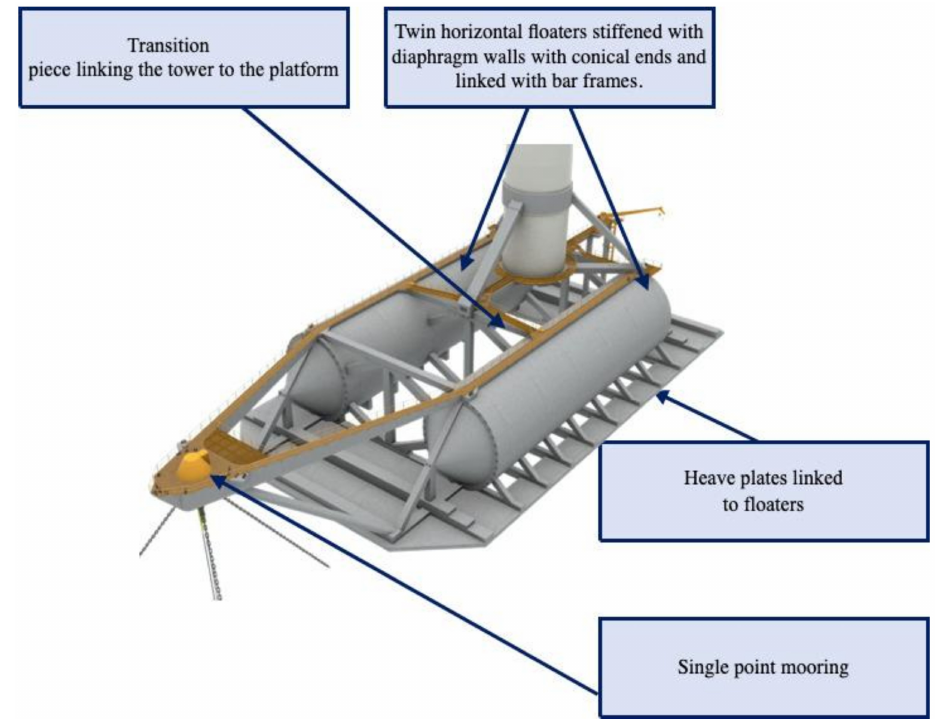
Figure 4. SATH ® platform main components. Source: It has been adapted from a figure courtesy of Saitec [31].